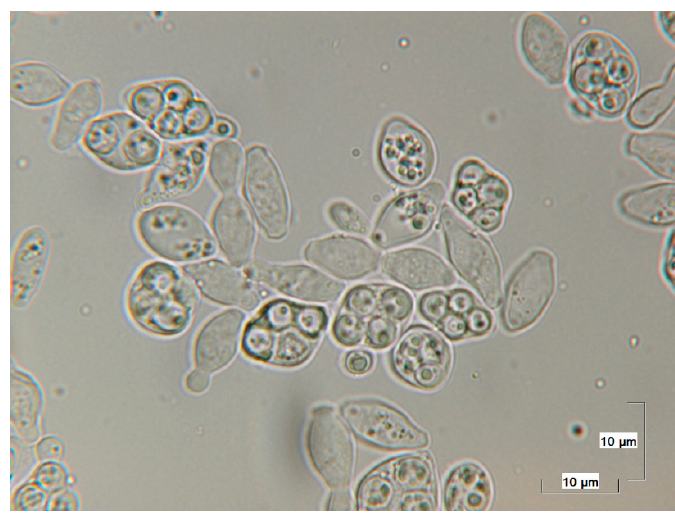
Figure 1. Apiculated cells of Saccharomycodes ludwigii at a magnification of 600×.